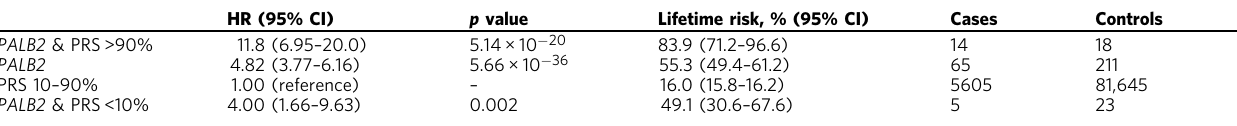
Population level was de fi ned as women with PRS between the 10th and 90th percentiles. The estimates were obtained from a Cox proportional hazards model on 109,371 women, without adjusting for multiple comparisons. All tests were two-tailed.